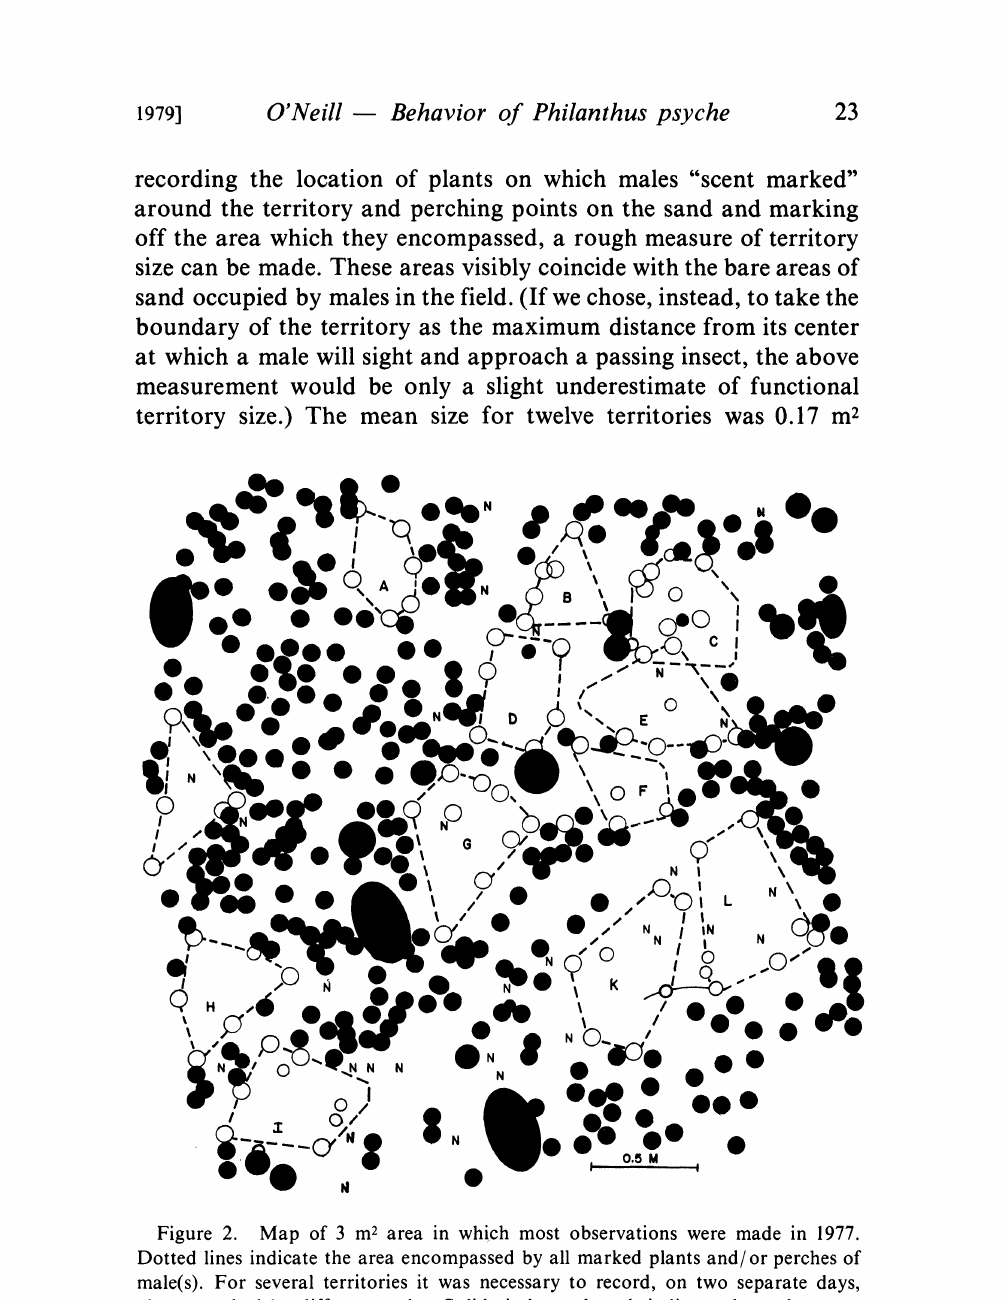
Figure 2. Map of 3 m area in which most observations were made in 1977. Dotted lines indicate the area encompassed by all marked plants and/or perches of male(s). For several territories it was necessary to record, on two separate days, plants marked by different males. Solid circles and ovals indicate plants that were marked by males. N indicates a nest